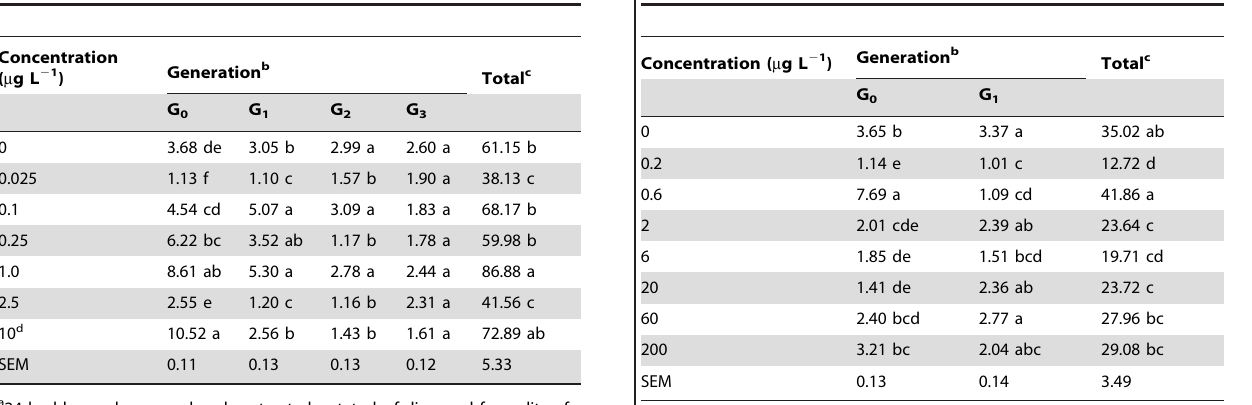
Table 3. Least-squares means of multigenerational fecundity a following two-day exposure of M. persicae to sublethal concentrations of imidacloprid.